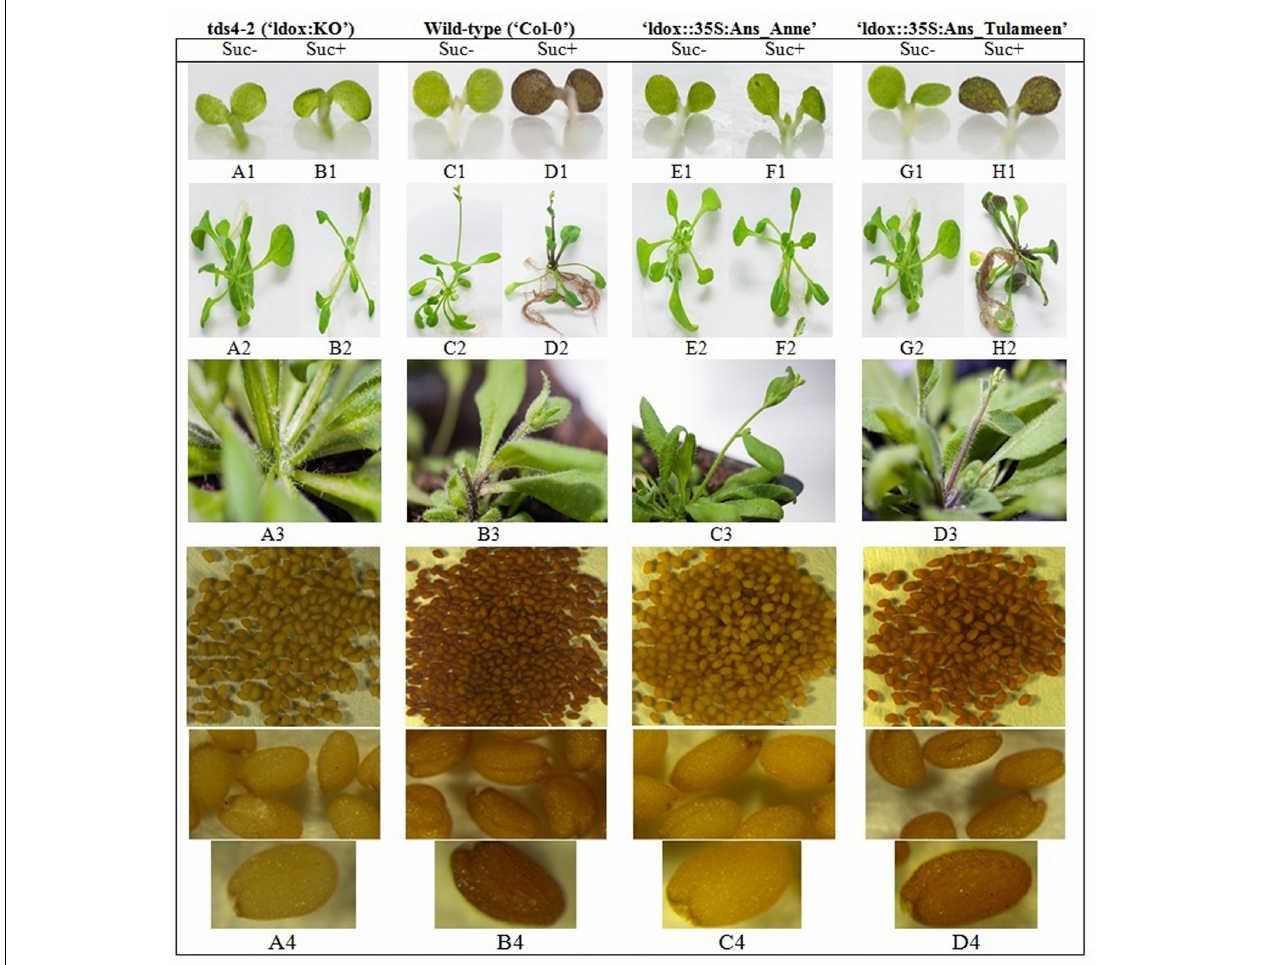
FIGURE 4 | Flavonoid phenotype of Arabidopsis transgenes in comparison to wild-type ( (cid:48) Col-0 (cid:48) ) and Idox knockout line (tds4-2; ‘ ldox:KO’). Control, wild-type, ‘ldox::35S:Ans_Anne’ and ‘ldox::35S:Ans_Tulameen’ seedlings grown in half MS without sucrose (Suc − ), 5 days old seedlings ( A1, C1, E1, G1 ) and 2 weeks old plantlets ( A2, C2, E2, G2 ), respectively. Control, wild-type, ‘ldox::35S:Ans_Anne’ and ‘ldox::35S:Ans_Tulameen’ seedlings grown on half MS with 5% sucrose (Suc+), 5 days old seedlings ( B1, D1, F1, H1 ) and 2 weeks old plantlets ( B2, D2, F2, H2 ), Respectively. Formation of anthocyanins was also obtained in 4 week old plants wild-type (B3) and ‘ldox::35S:Ans_Tulameen’ (D3) in comparison to control ‘ldox:KO’ (A3) and ‘ldox::35S:Ans_Anne’ (C3) lines. The seed coat color associated with presence of PA (B4,D4) or in absence of PA (A4,C4)